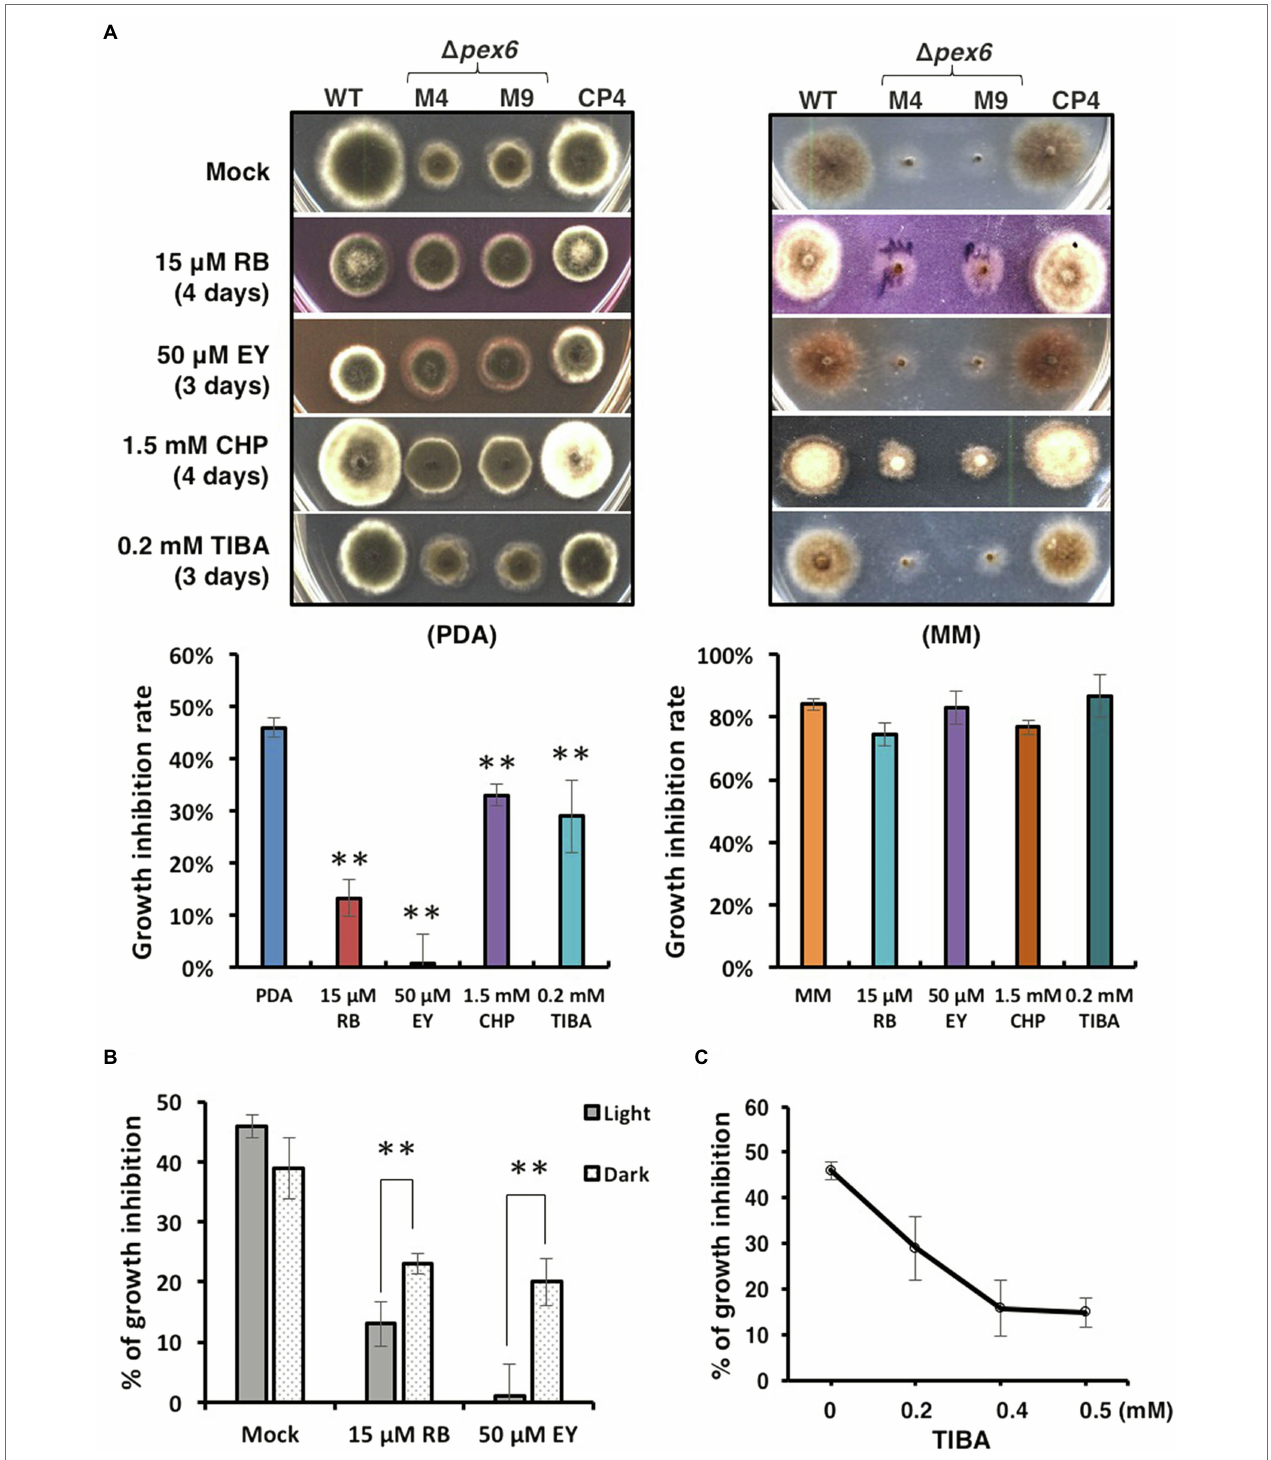
FIGURE 8 | Sensitivity tests. (A) Images of the wild-type (WT), the pex6 -deficient ( ∆ pex6 -M4 and M9), and the CP4 complementation strains grown on potato dextrose agar (PDA) or minimal medium (MM) amended with rose Bengal (RB), eosin Y (EY), 2-chloro-5-hydroxypyridine (CHP), or 2,3,5-triiodobenzoic acid (TIBA) for 3–4 days. PDA or MM was used a mock control. (B) Quantitative analysis of radial growth of WT and ∆ pex6 -M4 on PDA alone (mock) or PDA amended with RB or EY under constant light or in complete darkness for 3–4 days. (C) Decreased growth inhibition of ∆ pex6 -M4 in relation to WT on PDA amended with increased concentrations of TIBA. Growth inhibition rates were calculated by dividing the comparative difference of the growth by the wild-type growth and multiplying by 100. Means indicated by asterisks ( ** ) are significantly different from one another, p <